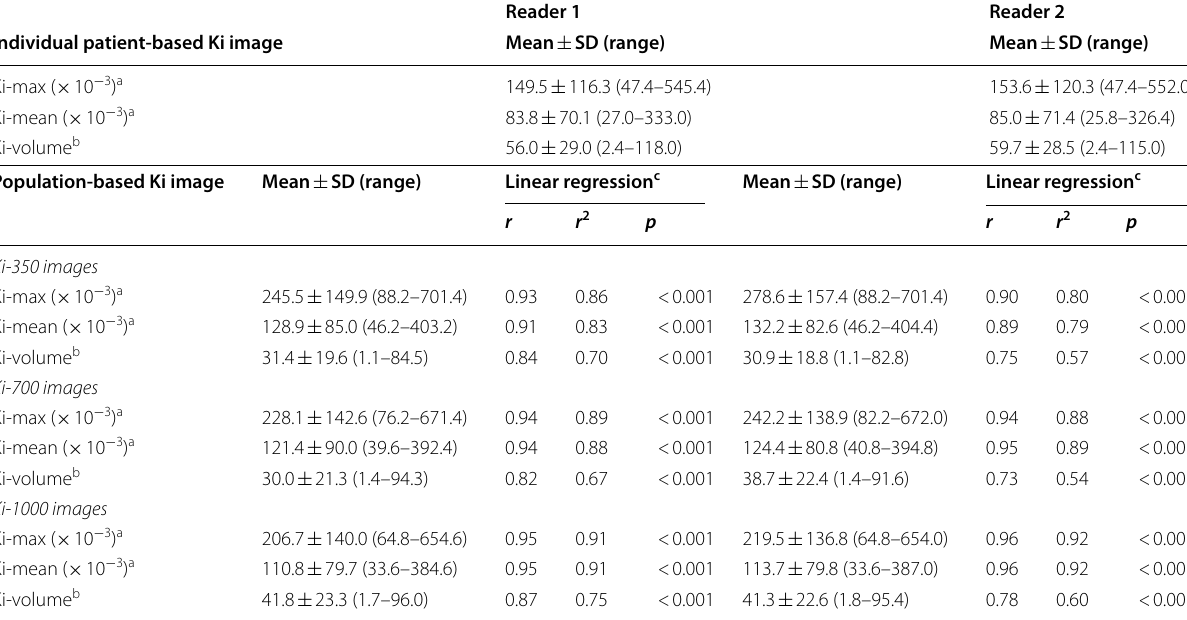
Table 2 Each Ki parameter value and correlations of Ki parameter values in individual patient-based and population-based Ki images of 51 positive